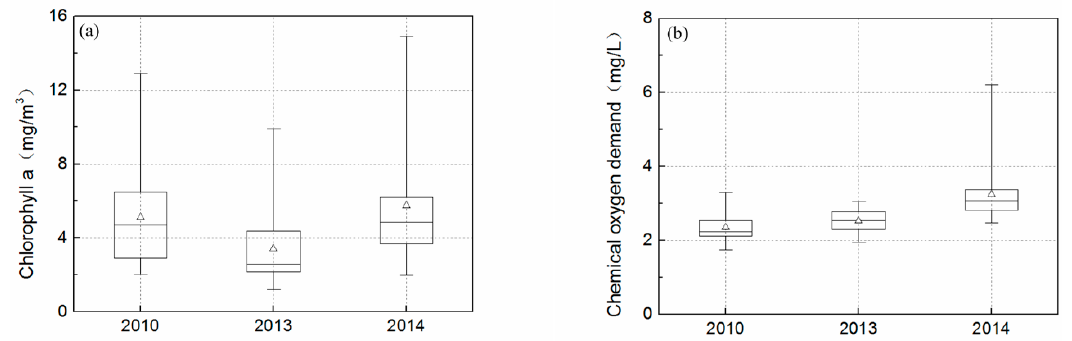
Figure 7. Variation of Chlorophyll a ( a ) and COD ( b ) in 2010, 2013, and 2014.